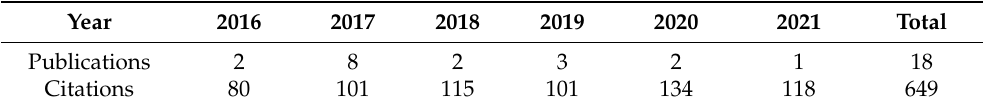
Table 2. Publication and citation counts based on the analysis pattern: TS = ((fossil fuels) AND energy security educ*). Source: Web of Science